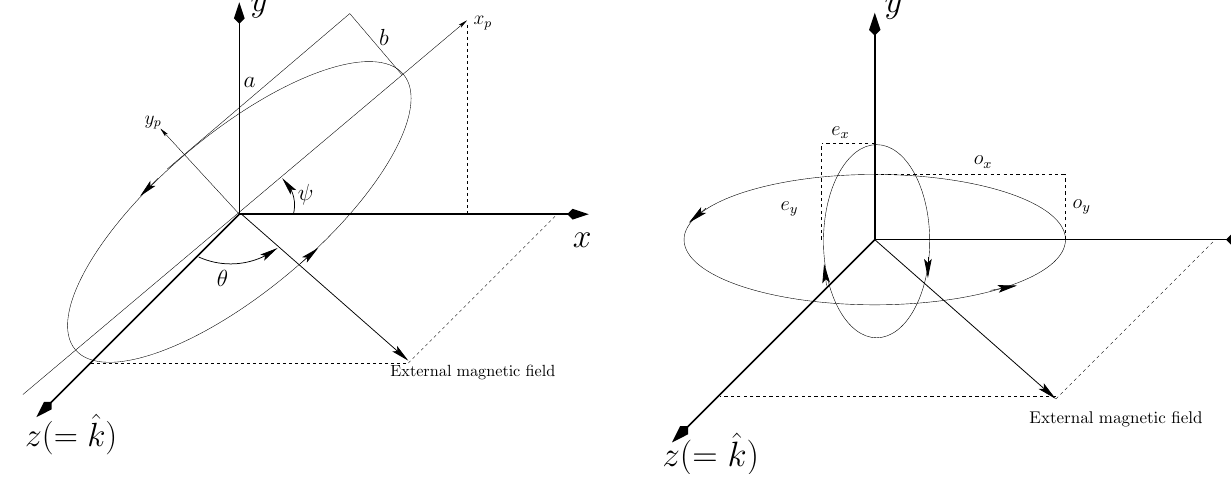
Fig. 2. The two magnetoionic modes predicted by Budden (1961) which exist from the decomposition of the wave in Fig. 1. The propagation direction of the modes ˆ k is in the z -direction and the polarization of interest is in the